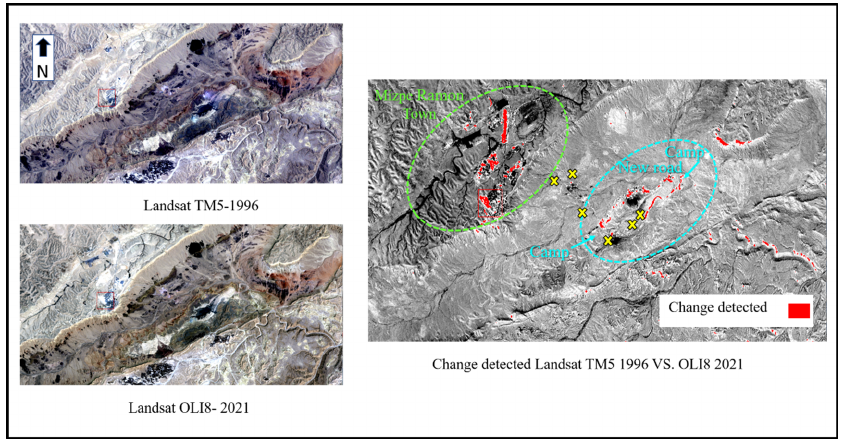
Figure 6. Spatial change detection result for MR, 1996 vs. 2021. Spectral test sites are marked by yellow Xs, detected changed pixels are colored in red.